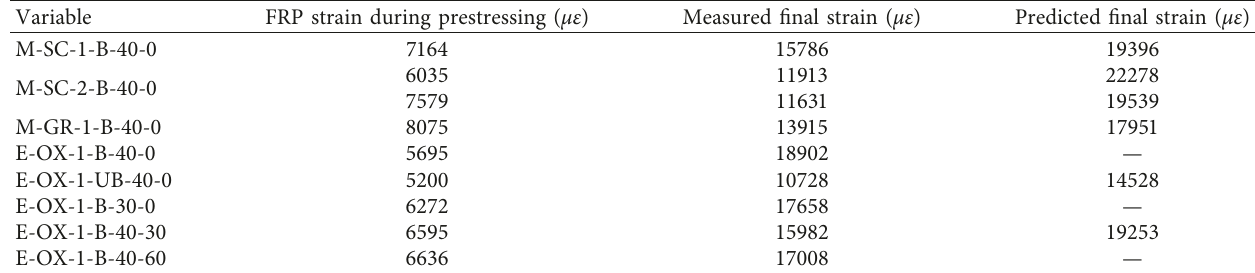
Figure 19: Strain distribution in cross section. (a) M-SC-1-B-40-0. (b) M-SC-2-B-40-0. (c) M-GR-1-B-40-0. Table 8: Designation of specimens and corresponding test